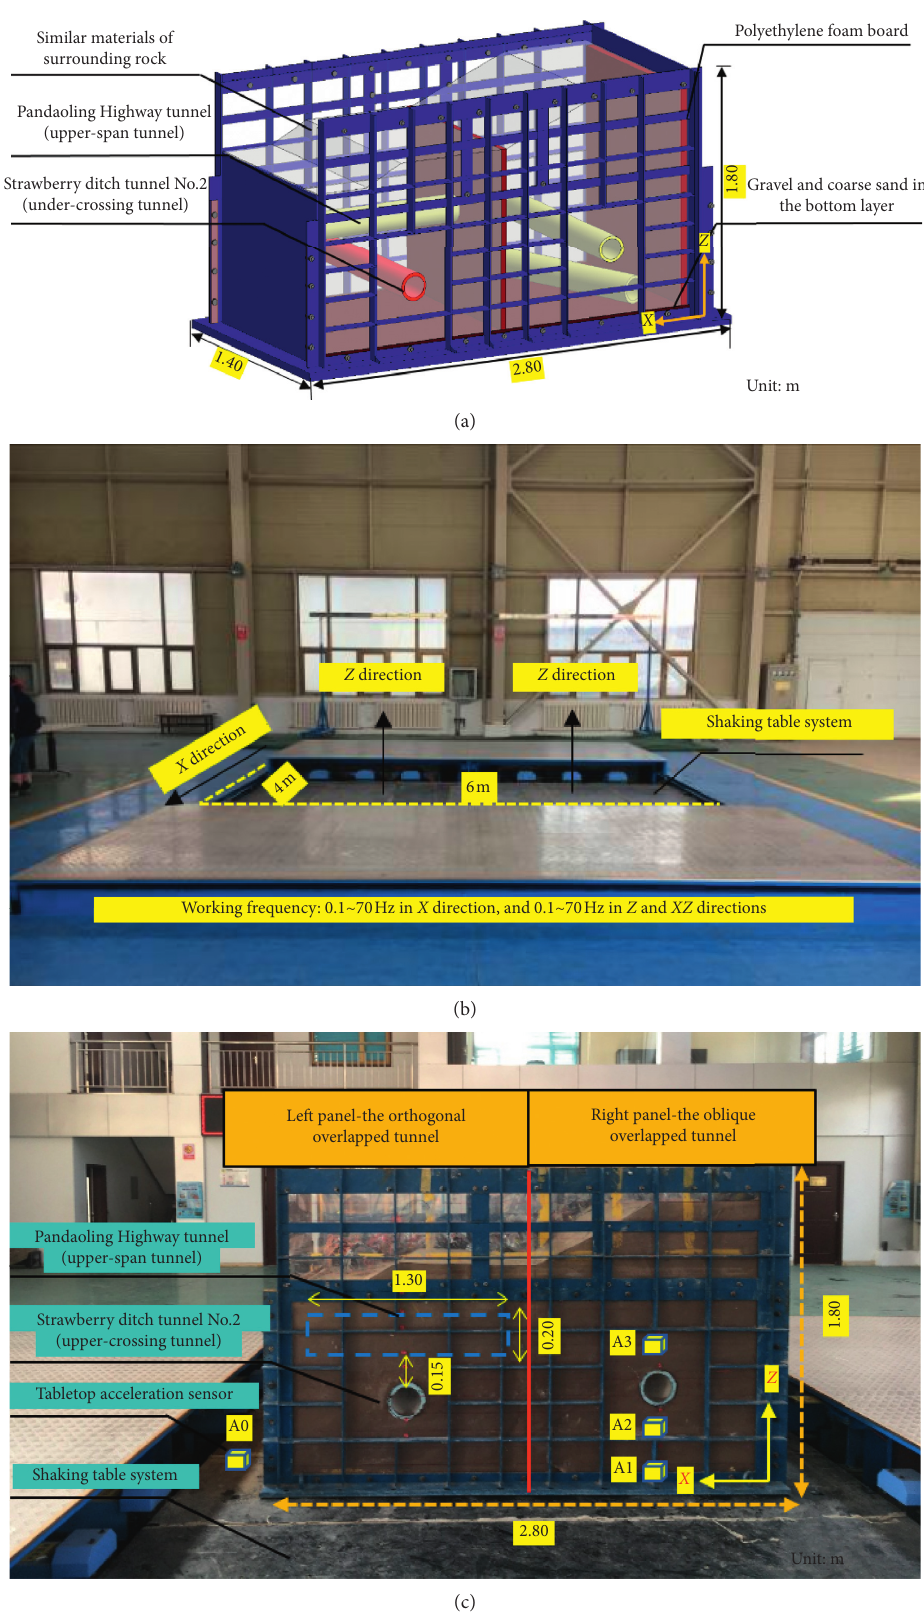
Figure 3: Layout of the test model: (a) sketch map; (b) shaking table system; (c) model